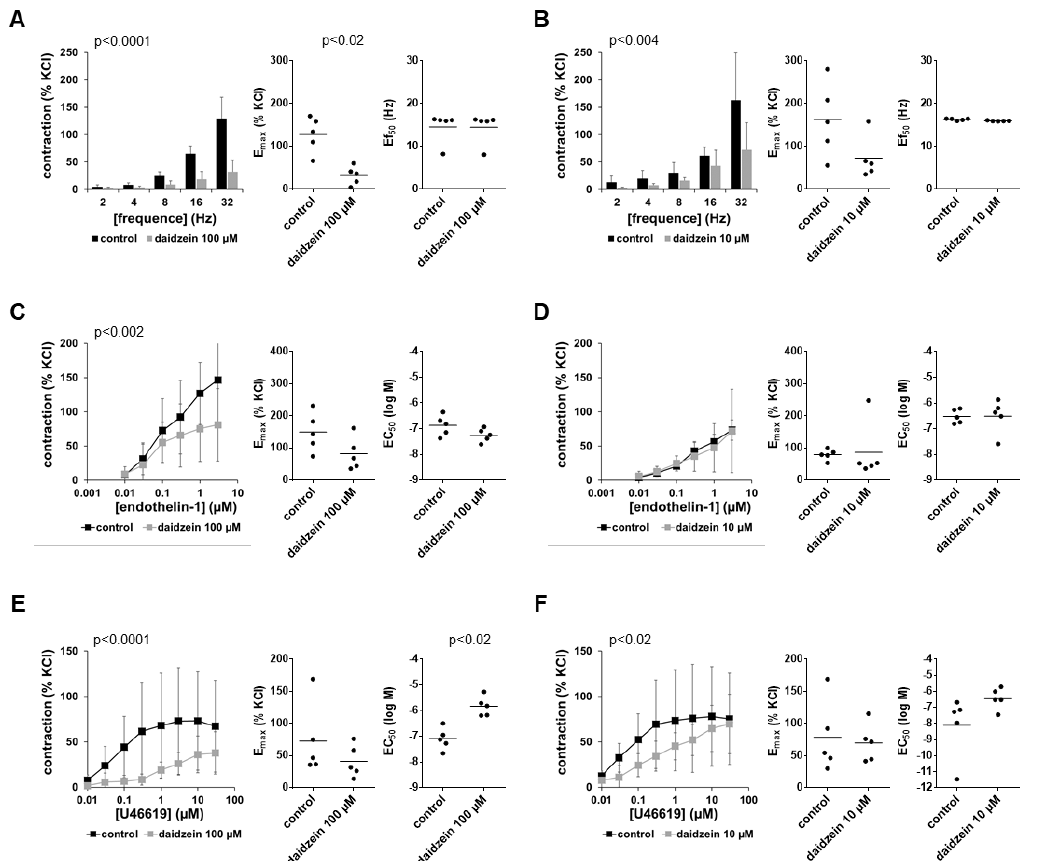
Figure 4. Effects of daidzein on EFS-induced and non-adrenergic contractions of human prostate tissues. Contractions were induced by EFS ( A , B ), endothelin-1 ( C , D ) and U46619 ( E , F ) in the presence of 100 µ M daidzein ( A , C , E ), 10 µ M daidzein ( B , D , F ) and corresponding amounts of solvent (DMSO) for the controls added 30 min before the construction of frequency and concentration–response curves. Data from experiments with tissues from n = 5 patients are shown in each diagram. In each experiment, tissue from one patient was allocated to the control and daidzein groups. Data are means ± SDs in frequency/concentration–response curves ( p -values for whole groups from two-way ANOVA), and E max , Ef 50 and EC 50 values are from all single experiments (calculated by curve fitting) in scatter plots ( p -values from two-tailed t